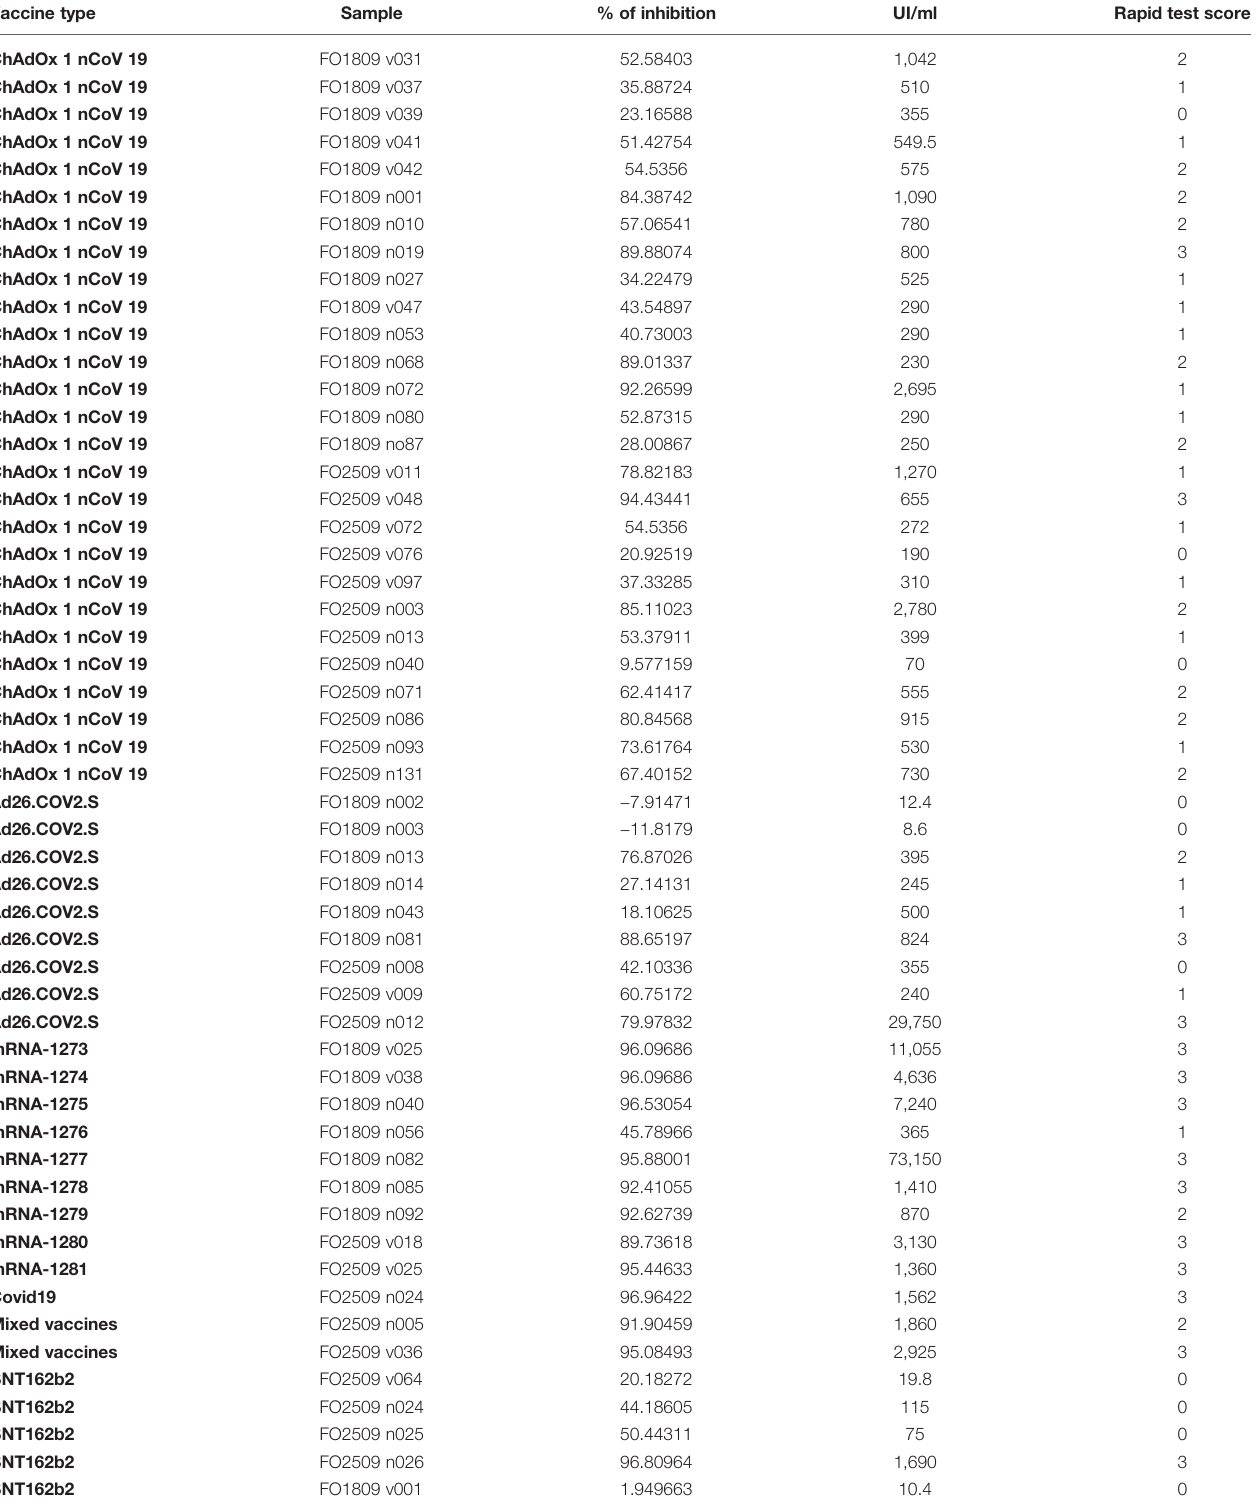
TABLE 2 | Comparison of anti-RBD antibody titers and neutralizing activity determined qualitatively as percentage of inhibition by an ELISA and qualitatively by a rapid test (see Materials and Methods ). Vaccine